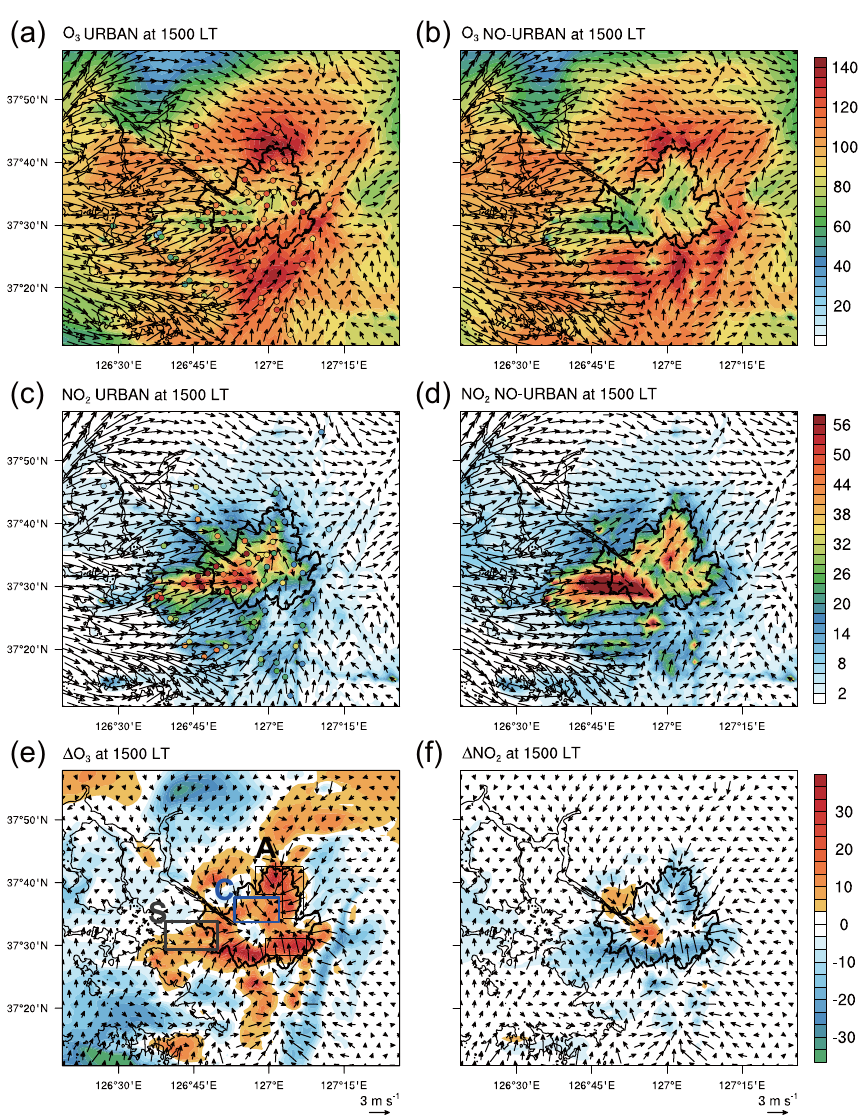
Fig. 3. Horizontal distributions of (a) O 3 and (c) NO 2 concentrations and horizontal wind at the lowest model level at 15:00 LT in the URBAN simulation. The circles in (a) and (c) show the observed O 3 and NO 2 concentrations, respectively. (b) and (d) are the same as (a) and (c) , respectively, but for the NO-URBAN simulation. (e) Differences in O 3 concentration and horizontal wind between the two simulations (URBAN minus NO-URBAN). (f) is the same as (e) but for NO 2 . The concentration units areppb. Region A, region C, and region S are marked in (e) by the three rectangles with a thin black line, with a thick blue line, and with a thick grey line,